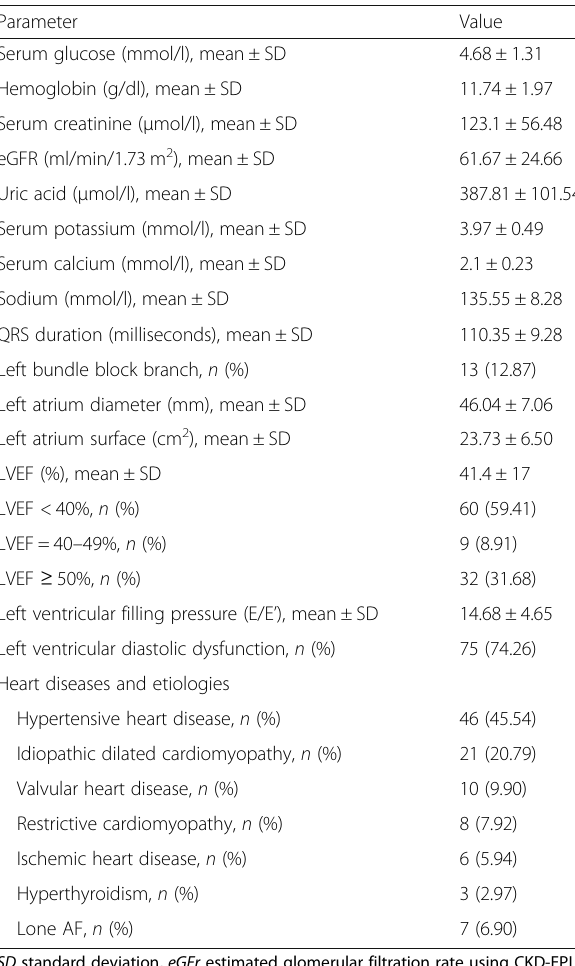
Table 1 Clinical baseline characteristics of the study population Characteristic